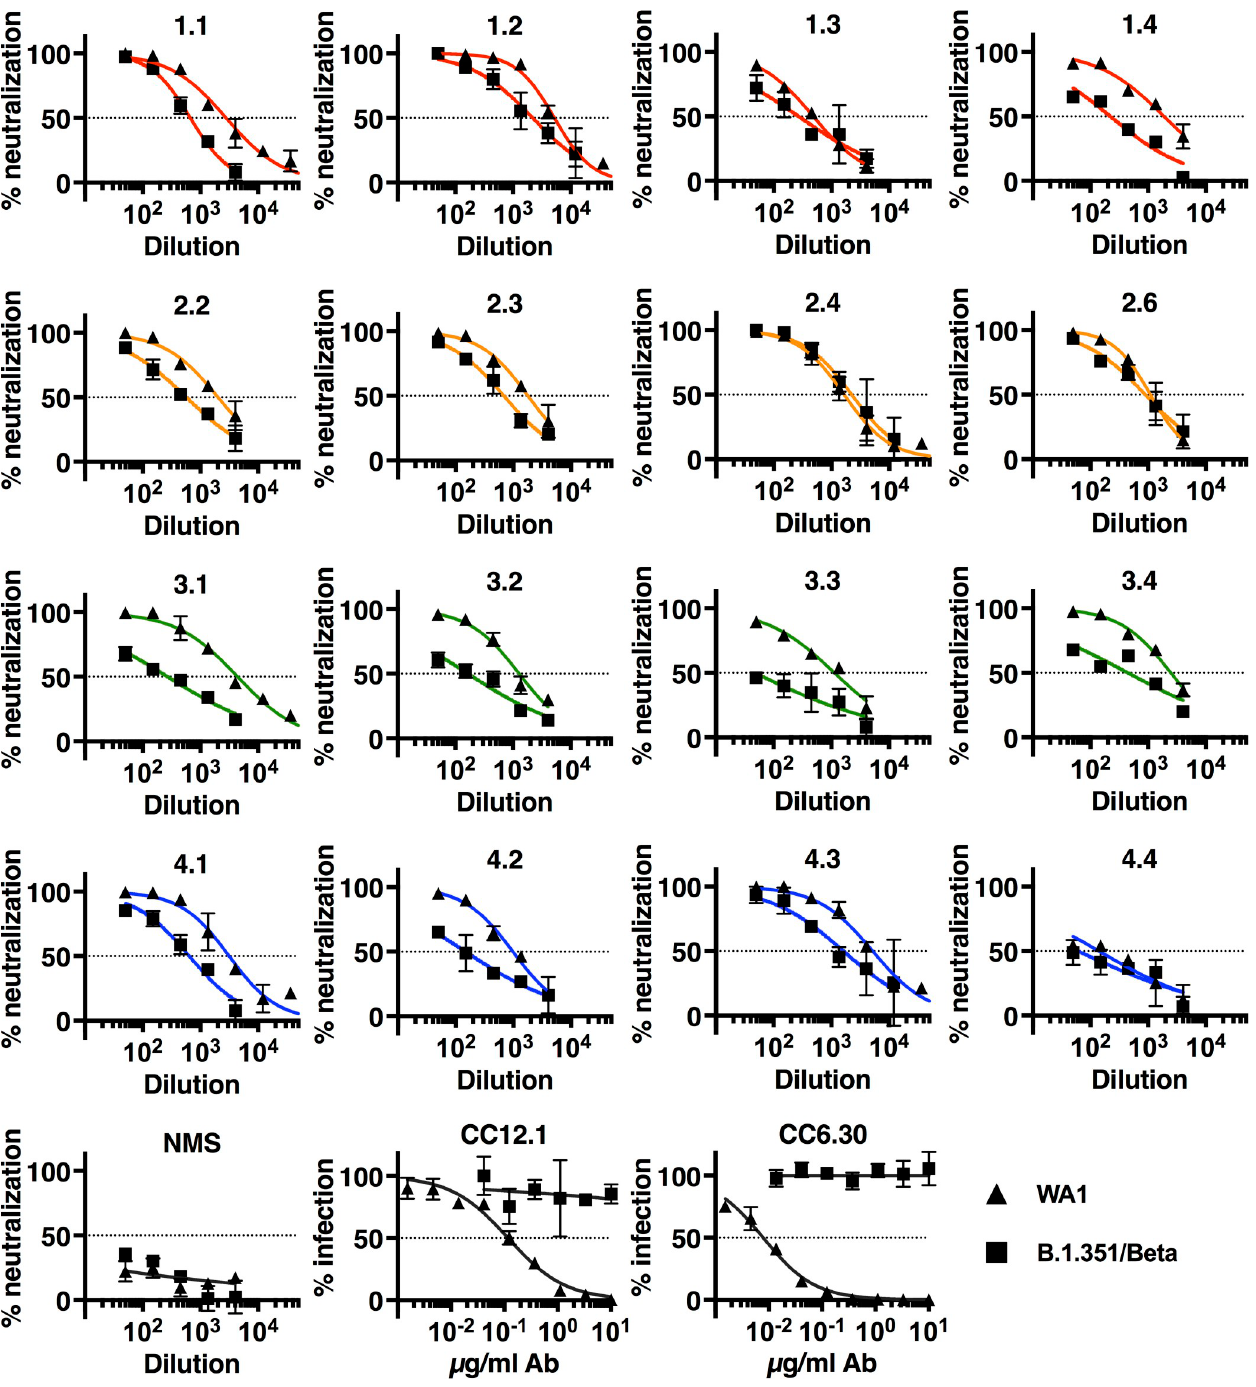
Fig 4. Neutralization of authentic SARS-CoV-2 WA1 isolate and VOCs B.1.351/Beta. Neutralization of authentic SARS-CoV-2 isolate WA1 and VOCs B.1.351 and B.1.617.2 by immune sera was measured by focus reduction neutralization test (FRNT) on TMPRSS2-Vero cells. 3-fold serial dilutions started at 1:50. Percent neutralization and percent infection are relative to media-only control. Data shown are the mean and SD of 2 biological replicates. Dotted lines mark 50% neutralization. Color scheme: red = group 1; orange = group 2; green = group 3; blue = group 4. NMS = normal mouse serum.